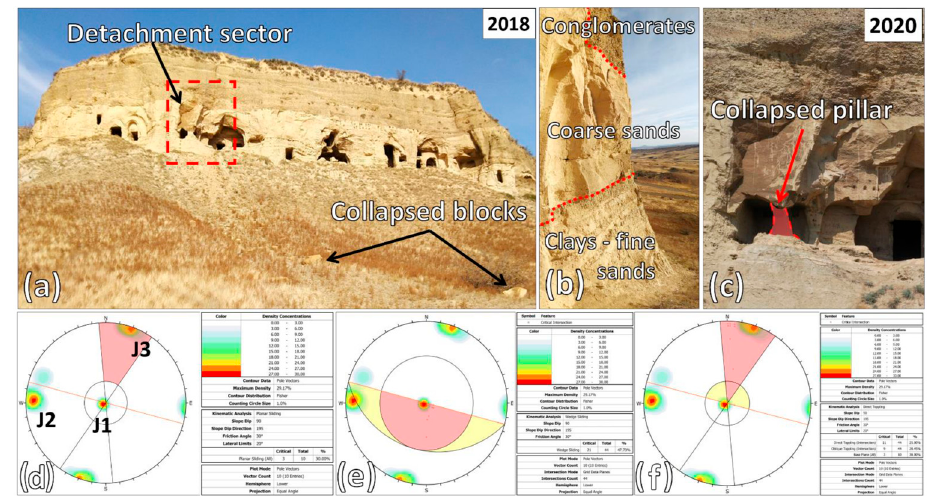
Figure 12. The Sabereebi monastery geological features: cliff face showing the chambers and the detached block in 2018 ( a ); stratigraphic sequence ( b ); the detachment sector in 2020, showing the collapsed pillar ( c ); 2D kinematic analysis: wedge failure mechanism ( d ); planar failure mechanism ( e ); direct toppling ( f ).